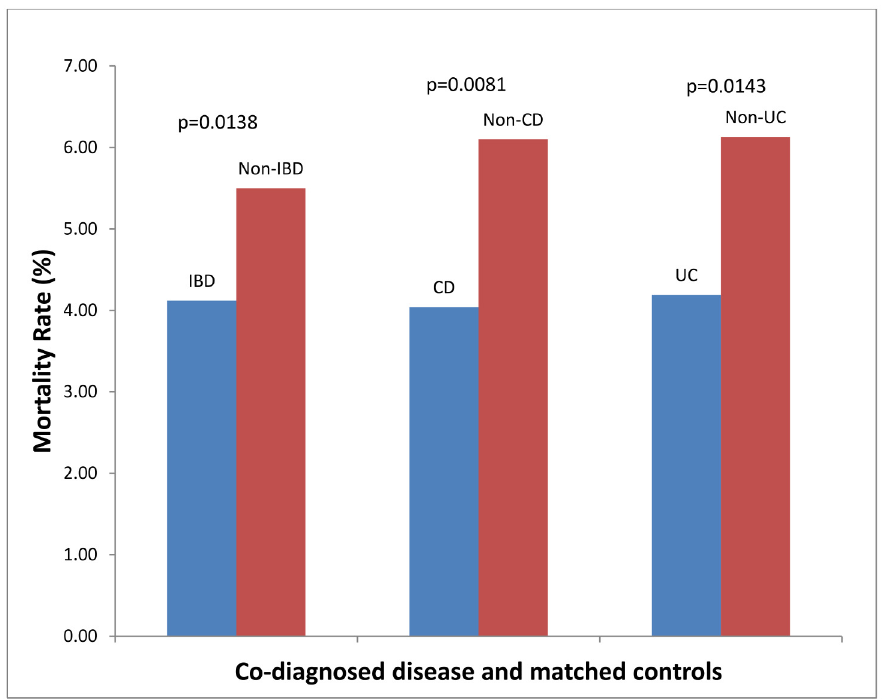
Fig 1. Hospital Mortality Rates for Co-Diagnosis and Matched Controls for Patients Hospitalized with Primary Diagnosis of Acute MI (AMI).